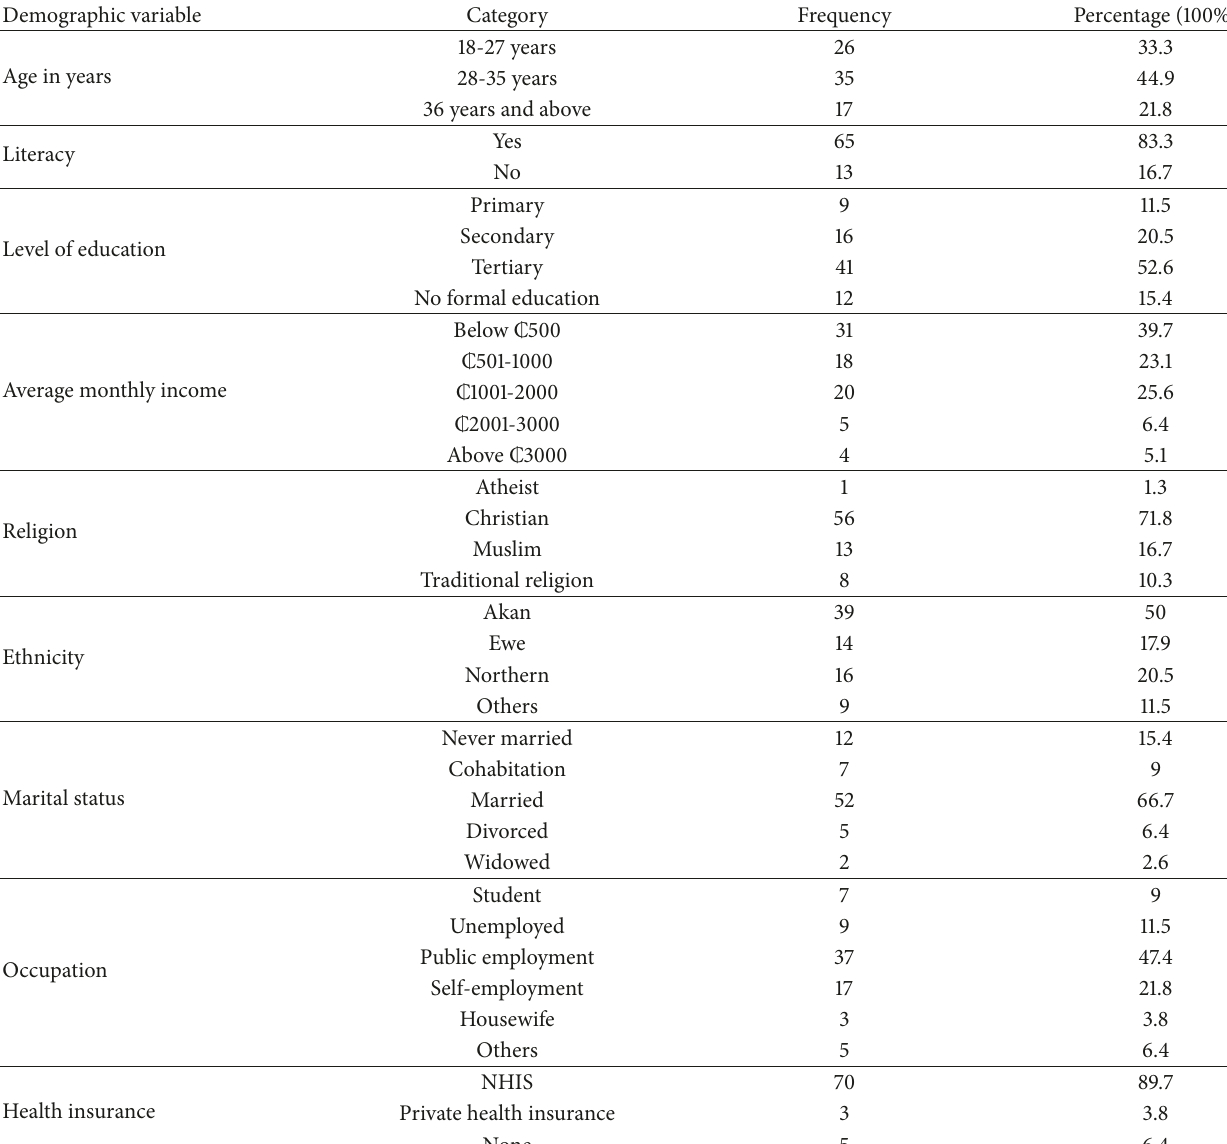
Table 1: Demographic characteristics of